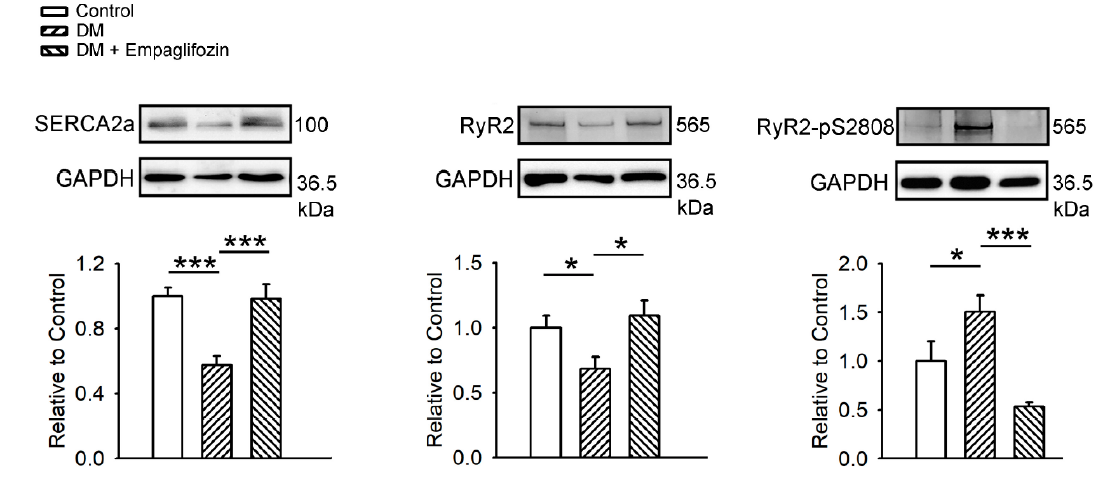
Figure 7. Ca 2+ regulation proteins in control, diabetes mellitus (DM), and empagliflozin-treated DM (DM + empagliflozin) ventricular myocytes. Representative immunoblot and average data of sarcoplasmic reticulum ATPase (SERCA2a), ryanodine receptor 2 (RyR2), and phosphorylated RyR2 at serine 2808 (RyR2-pS2808) from control (N = 5), DM (N = 5), and DM + empagliflozin (N = 5) rat ventricular myocytes. Densitometry was normalized to glyceraldehyde 3-phosphate dehydrogenase (GAPDH) as an internal control. N = number of rats; * p < 0.05; *** p < 0.005.